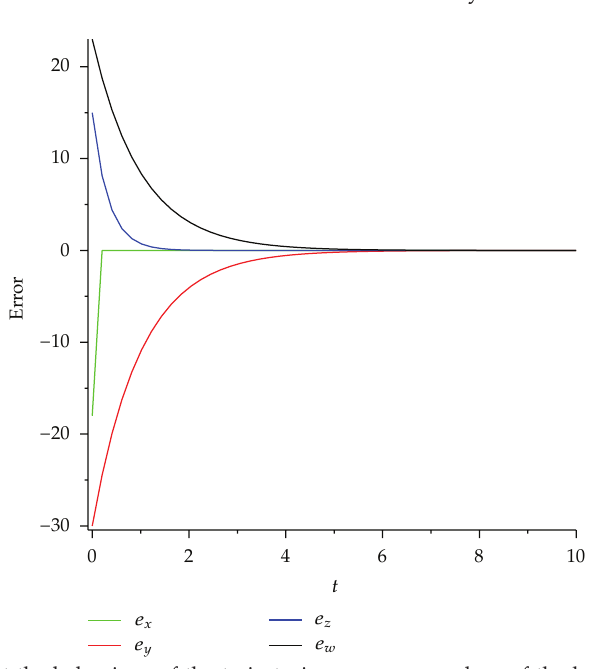
Figure 7: It shows that the behaviour of the trajectories e x , e y , e z , and e w of the hyperchaotic L¨u system error system tends to zero as t tends to 5 when the scaling factor α (cid:8) −